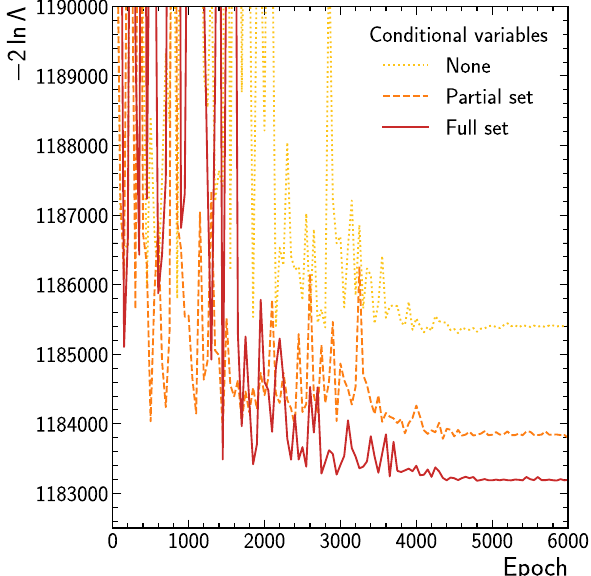
Fig. 4 Example of hyperparameter optimization where different con- figurationsaretested.Lineswithdifferentcolorscorrespondtodifferent numbers of dimensions of the random latent spaces given as input to the generator model